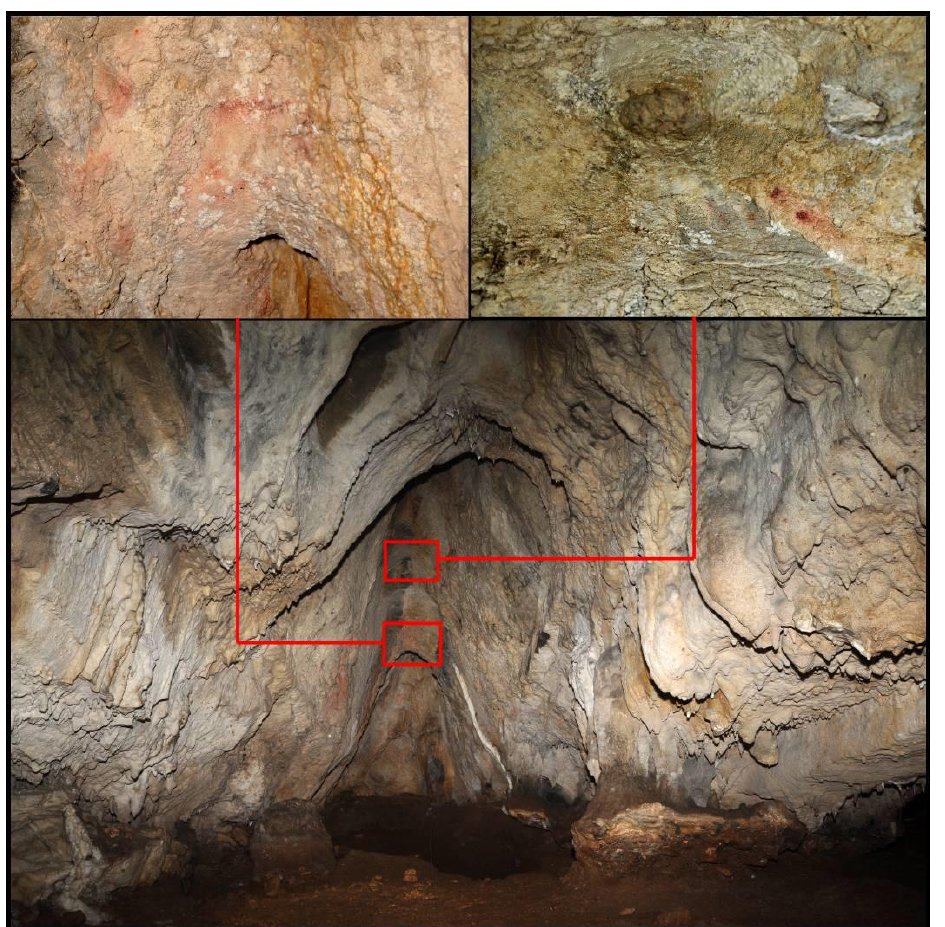
Figure 9. Marks and points in the Large Chamber of the Saint-Martin